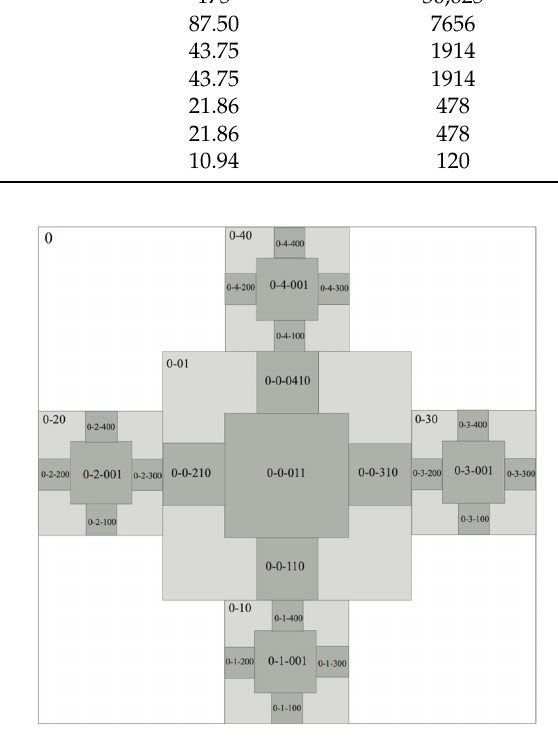
Table 1. Sample cells according to their hierarchical level, size, and surface percentage: iteration steps 0–2.